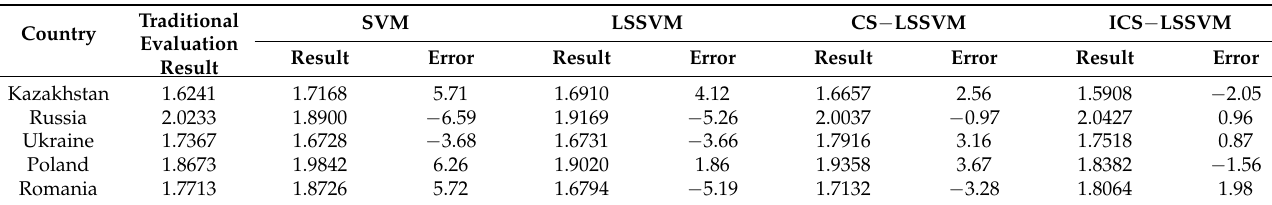
Table 9. Estimation results of the test samples.